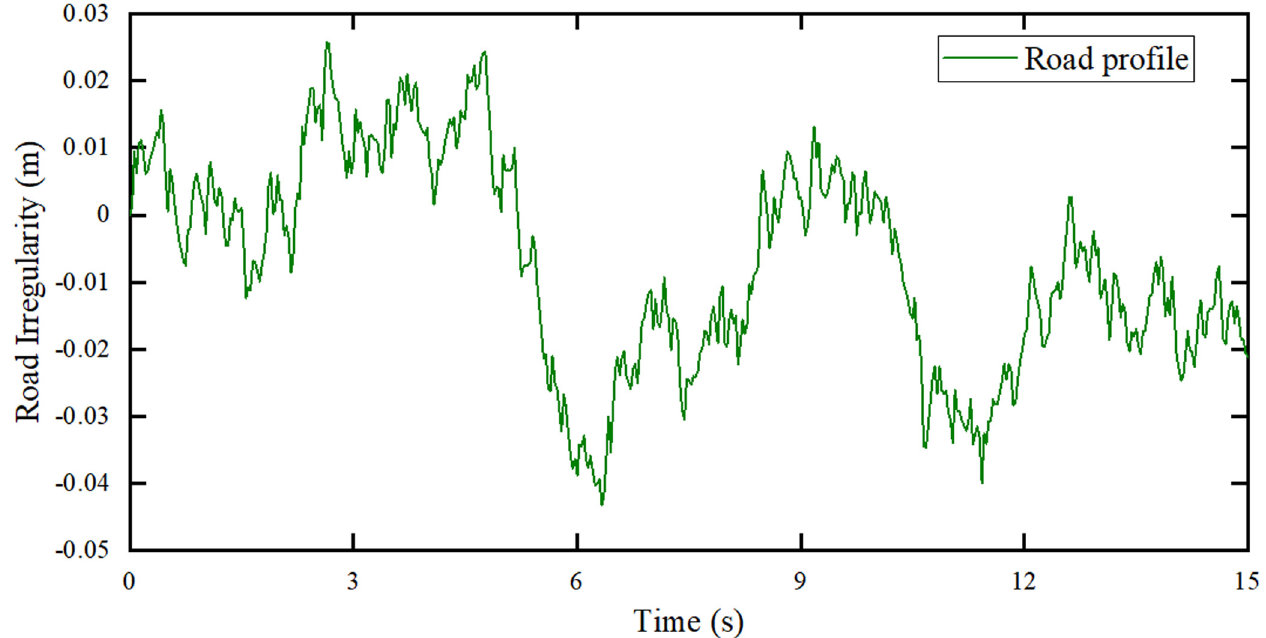
Fig. 9. D-grade random road pro fi